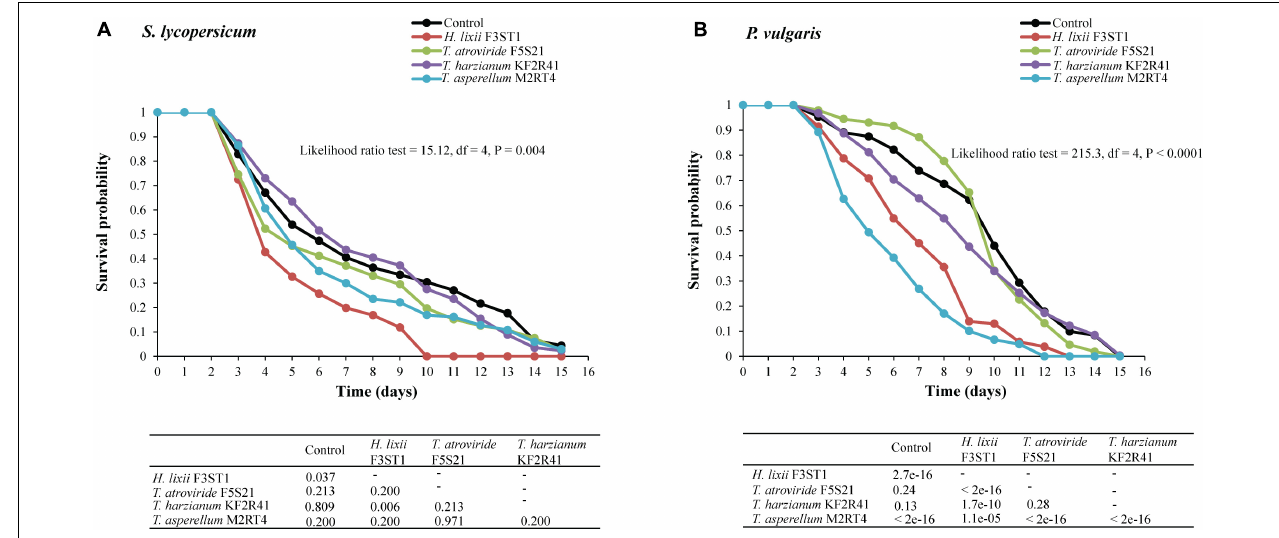
FIGURE 4 | Survival curves of T. vaporariorum adults after exposure to 3-week-old endophytically colonised S. lycopersicum (A) and P. vulgaris (B) plants by different fungal isolates of H. lixii F3ST1, T. asperellum M2RT4, T. atroviride F5S21, and T. harzianum KF2R41.